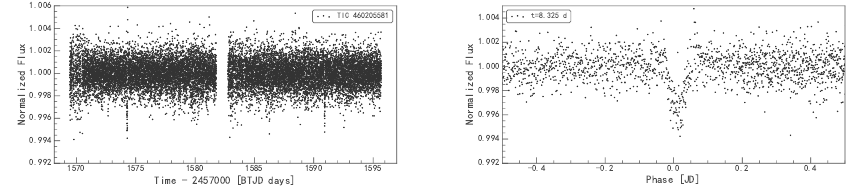
Figure 5. TESS light curve of TOI-837 (Sector 10). ( Left ): the detrended light curve. ( Right ): the phase-folded light curve to the period of 8.325 days. HD 63433 This star is a member of the UMa moving cluster. It has a mass of ∼ 1 M (cid:12) and a radius of ∼ 0.9 R (cid:12) . It was observed by TESS during Sector 20. The raw light curve shows